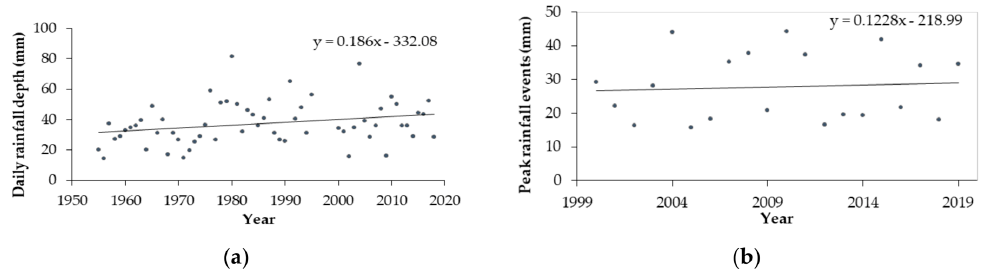
Figure 4. Trend analysis for station 2072 using automatic and daily records. ( a ) Annual maximum daily Supplementary Materials: The following are available online at www.mdpi.com/xxx/s1, Table S1: Established rainfall depth. ( b ) Annual Peak rainfall comparison of the IDF relationship estimated through different methods for station 2072 for different return periods, Table S2: Established comparison of IDF relationship estimated through different methods for the station 2036 for different return periods, Table S3: Established comparison of the IDF relationship estimated through different methods for the station 2035 for different return periods.